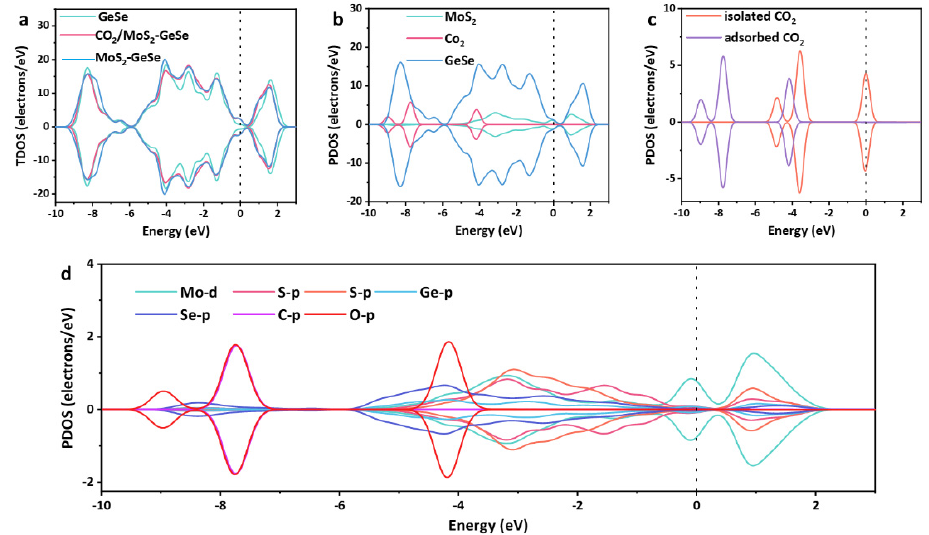
Figure 2. The TDOS and PDOS analyses of the CO 2 /MoS 2 –GeSe monolayer. The Fermi level is set at zero. ( a ) TDOS of CO 2 /MoS 2 –GeSe monolayer. ( b ) PDOS of CO 2 /MoS 2 –GeSe monolayer. ( c ) PDOS of two CO 2 . ( d ) PDOS of CO 2 /MoS 2 –GeSe monolayer with